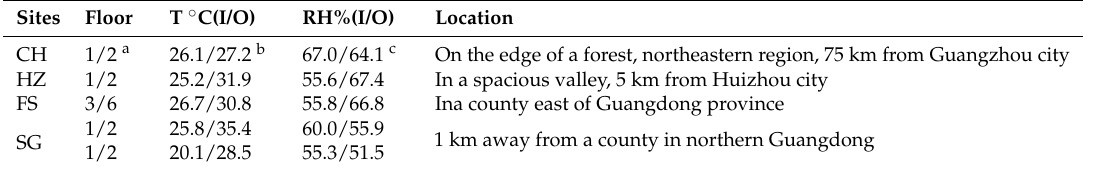
Table 1. General description of hot spring hotel locations and indoor/outdoor air